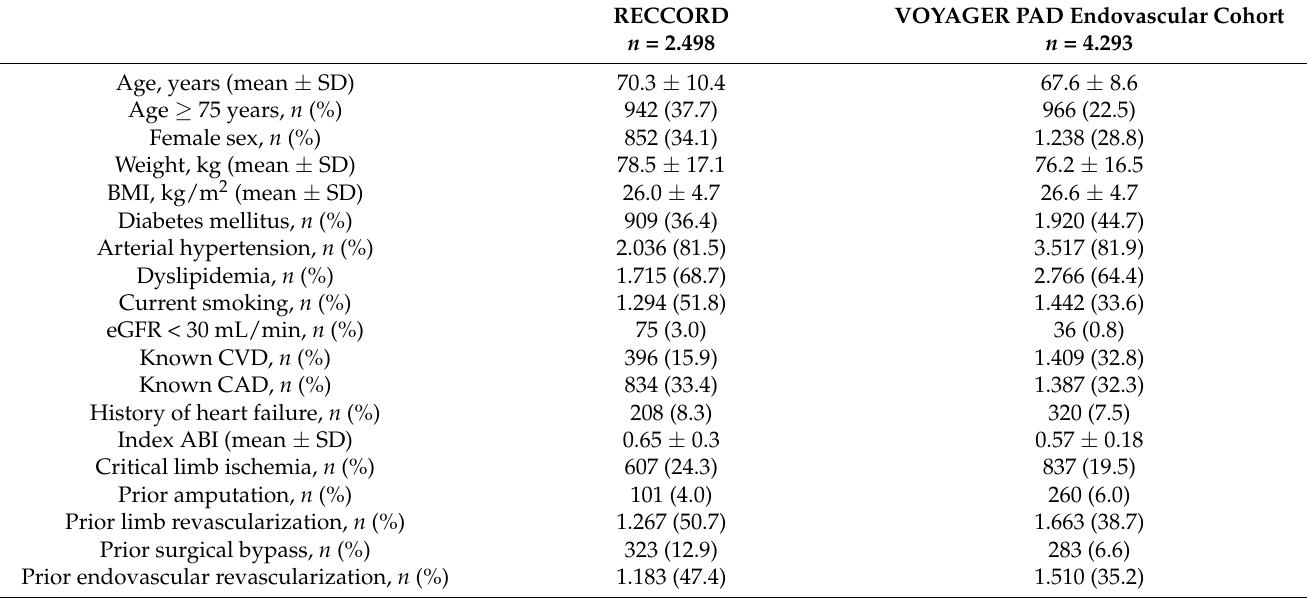
Table 1. Comparison of demographic and clinical characteristics between patients treated in the registry and the